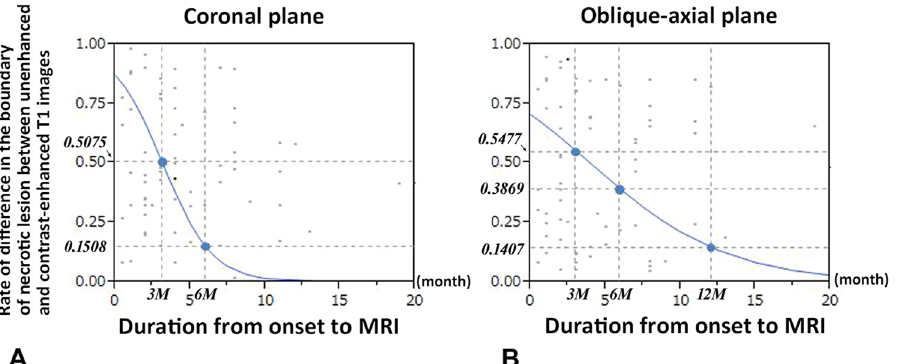
Figure 8. Simple logistic regression analyses for the relationship between the rate of presence of discrepancy in the definition of the boundary of necrotic lesion between unenhanced and contrast-enhanced T1 images and the duration from the onset of hip pain to MR imaging examination. ( a ) Results of the mid coronal slice. The rates of discrepancy 3 months (M) and 6 months after the onset are 0.5075 and 0.1508, respectively. ( b ) Results of mid oblique-axial slice. The rates of discrepancy 3, 6, and 12 months after the onset are 0.5477, 0.3869, and 0.1407,